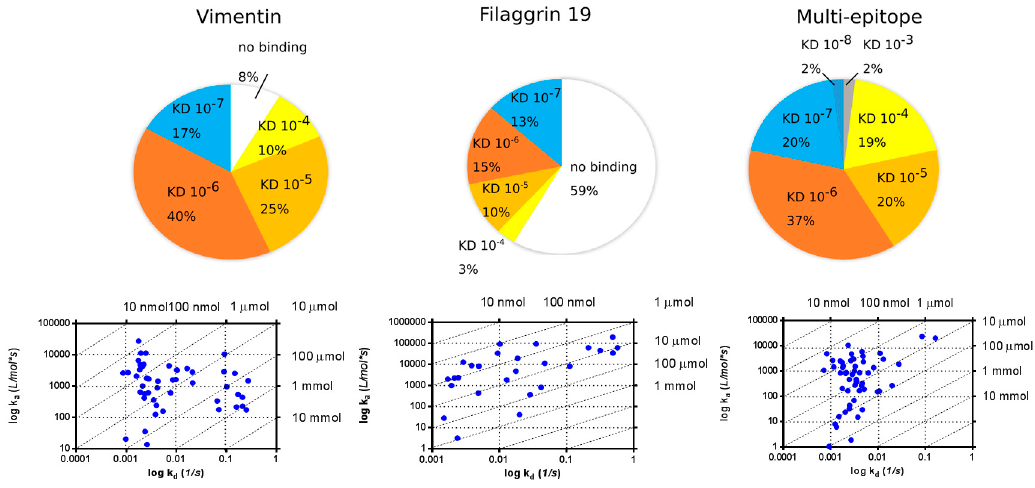
Figure 5. Distribution of apparent K D values of serum antibodies as measured from RA samples on GLH chip ( top ); and isoaffinity diagrams ( bottom ).